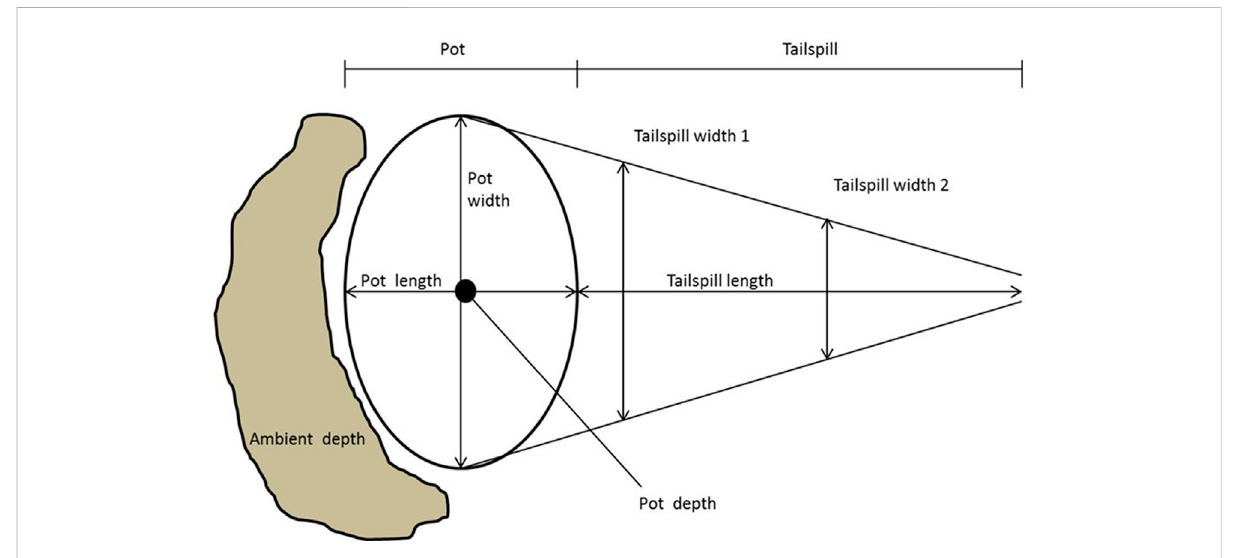
FIGURE 2 Diagram showing measurements taken within a